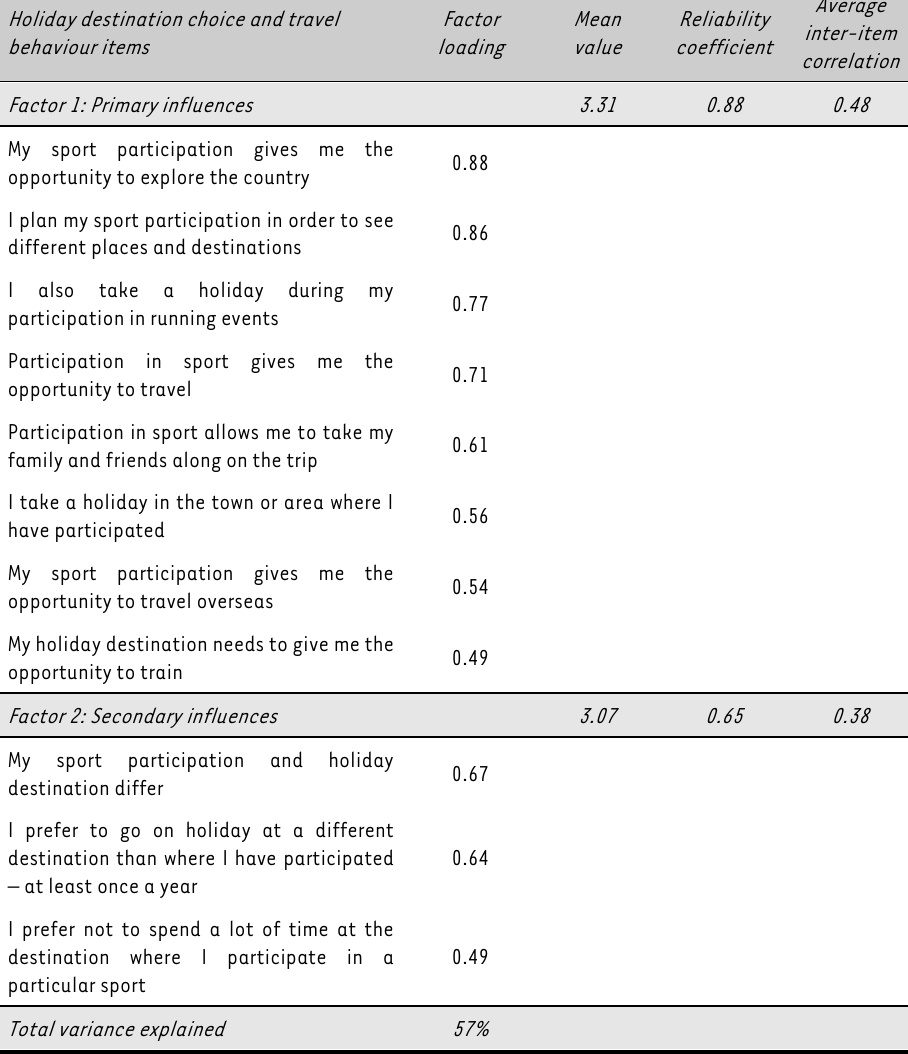
Results of factor analysis of the influence of sport participation on holiday destination choice and travel behaviour Holiday destination choice and travel behaviour